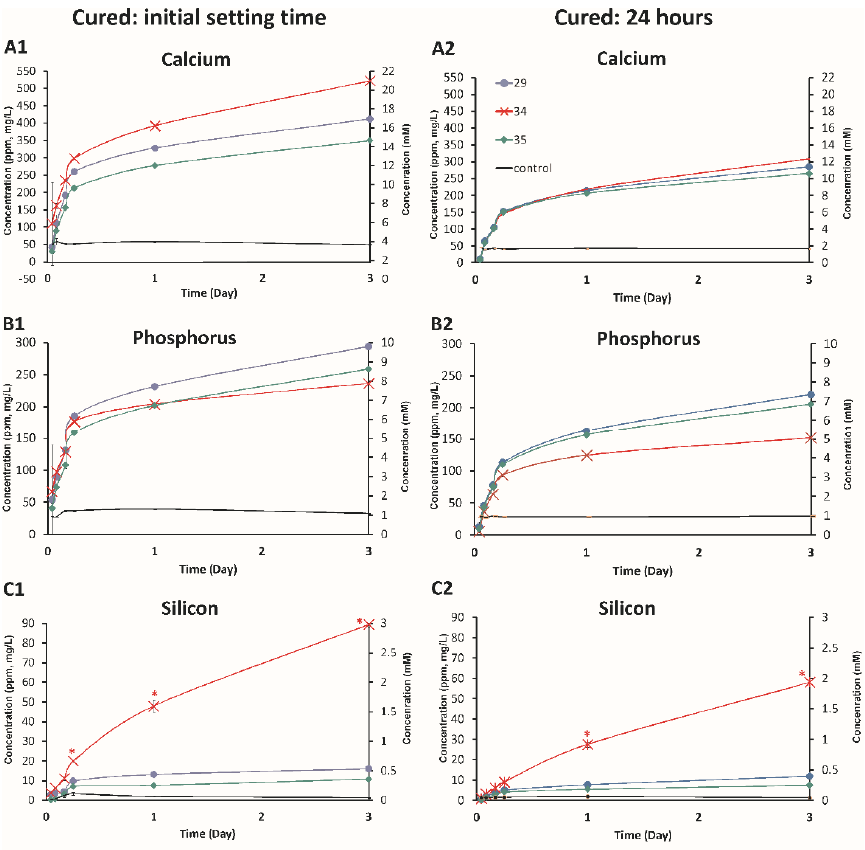
Figure 7. Effect of curing time on ion release profiles. Cumulative ion release profiles for calcium ( A ), phosphorus ( B ), and silicon ( C ) for samples cured for the initial setting time ( A1 – C1 ) or 24 h ( A2 – C2 ), via the ICP ‐ OES analysis. Sample dimensions are 1.6 mm × 1.6 mm (disc). * indicate p < 0.01 for comparisons made between all groups, compared to the highest eluting formulation (#34) (Games − Howell).